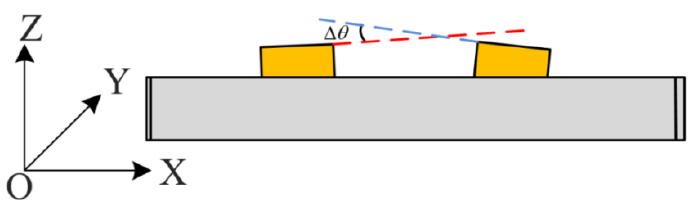
Figure 6. The pitch between two elliptical paraboloids.